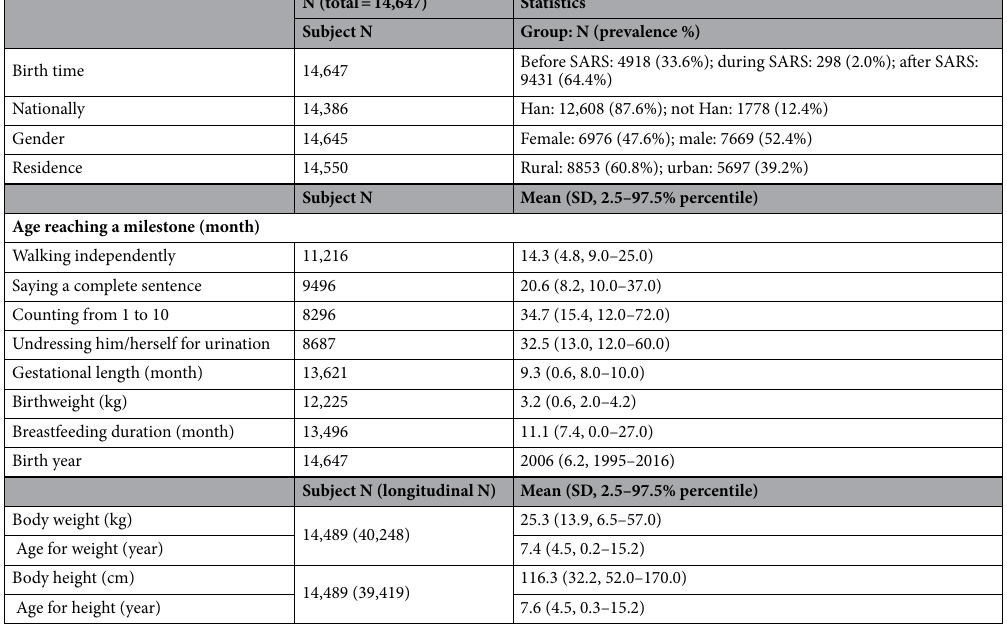
Table 1. Summary of population